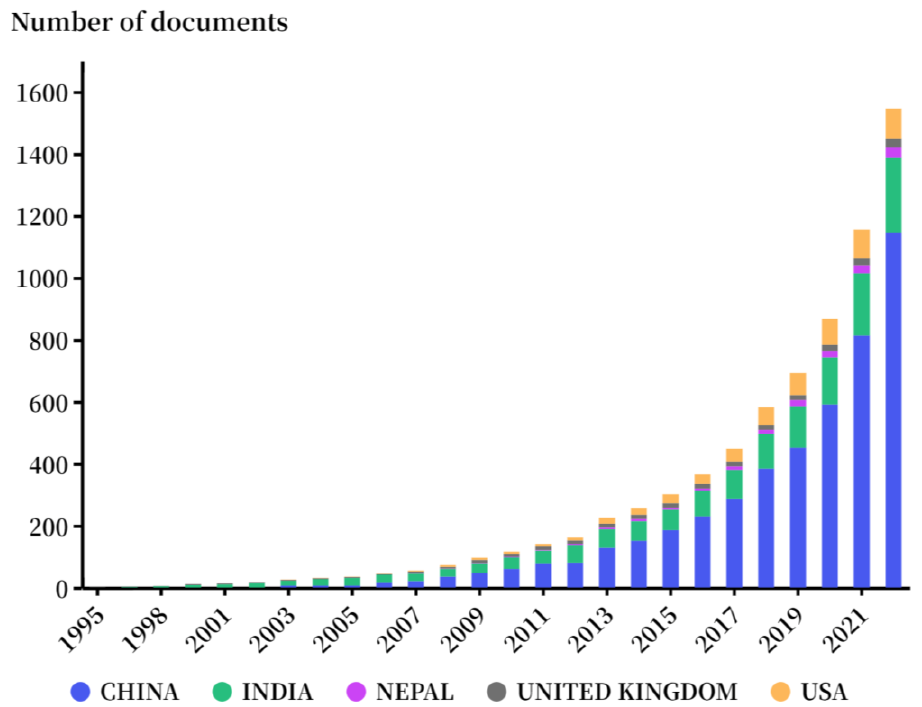
Figure 8. Gradual growth trend of the number of documents issued by the top three countries publishing about the ecological and environmental effects of land use and cover changes (LUCC) on the Qinghai – Tibetan Plateau (QTP).